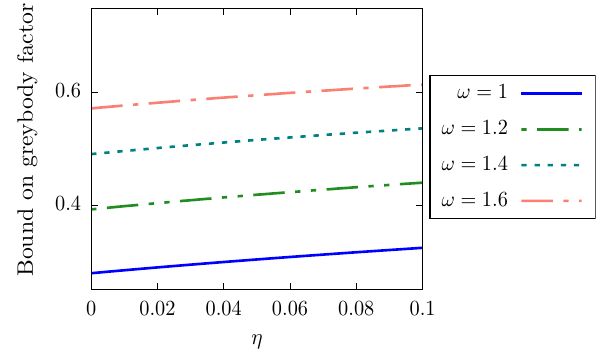
Fig. 7 In the above figure the lower bound on the greybody factor in a deformed spacetime for m = 0 is plotted with respect to varying η for different fixed ω . We have set the other parameters at l = 1, r s = 1, and a = 0 . 05. We note that the quantity a ω (cid:4) 1 so that the approximation of Eq. (17) can be made for the Spheriodal harmonics eigenvalues